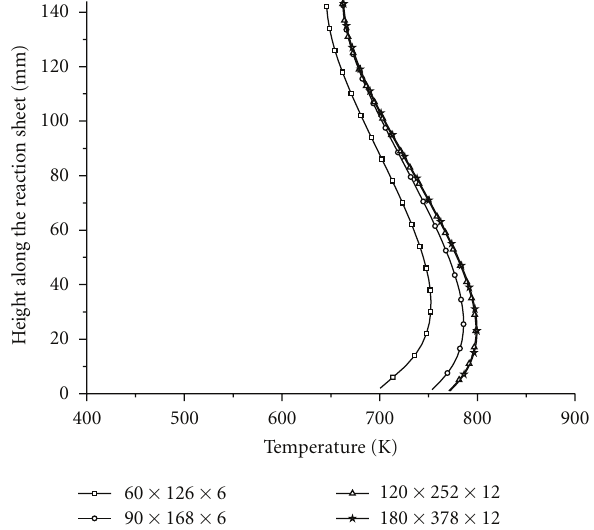
Figure 3: Steady-state average hydrogen concentration in the recombiner section for REKO facility, comparison of CFD results with experimental results for inlet hydrogen mole fraction 2% & 4% and temperature 343 K.